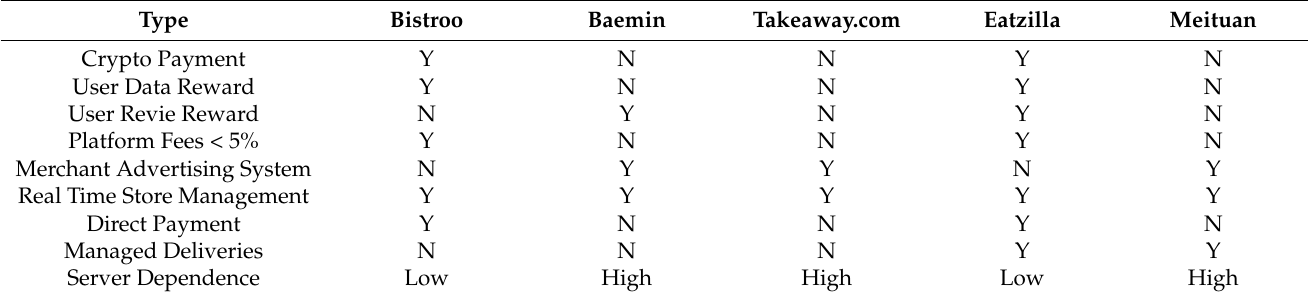
Table 1. Comparison of the status of blockchain food delivery platforms.